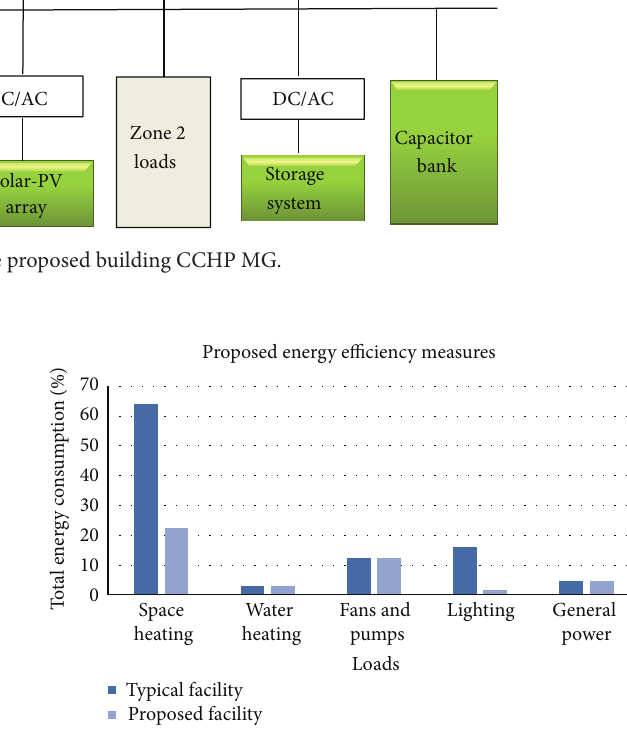
Figure 5: Load distribution of the building: typical versus